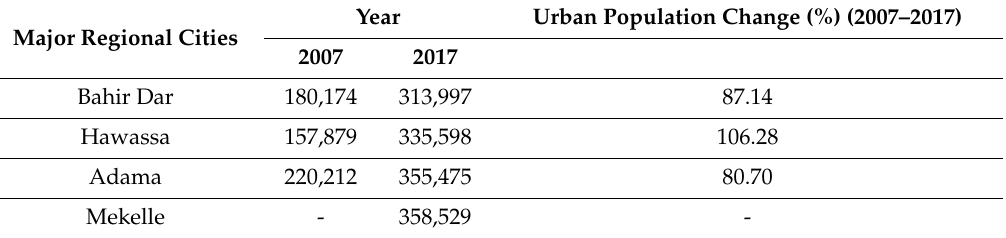
Source: Statistical Agency of Ethiopia [14,19]. Urban population